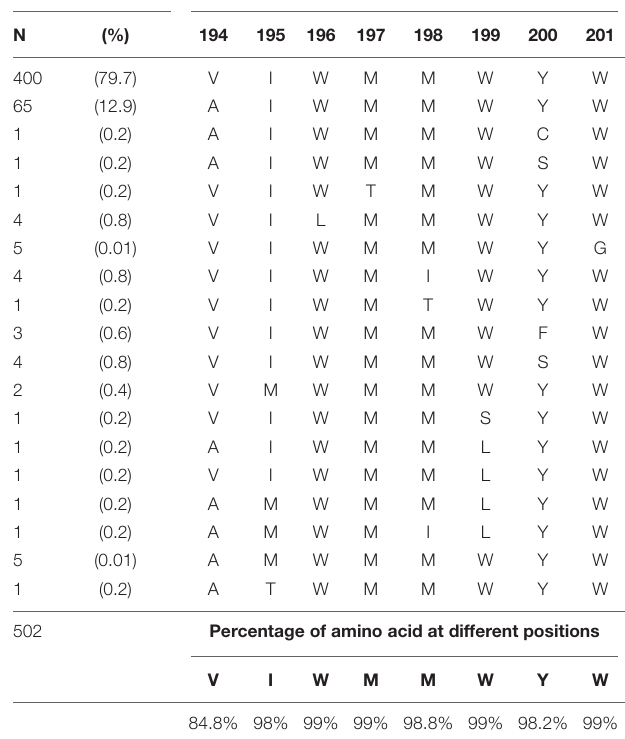
TABLE 3 | Amino-acid sequence of the HDV matrix domain within the cytosolic loop II of the HBV envelope at position 194 to 201 of each studied sample ( N = 502).